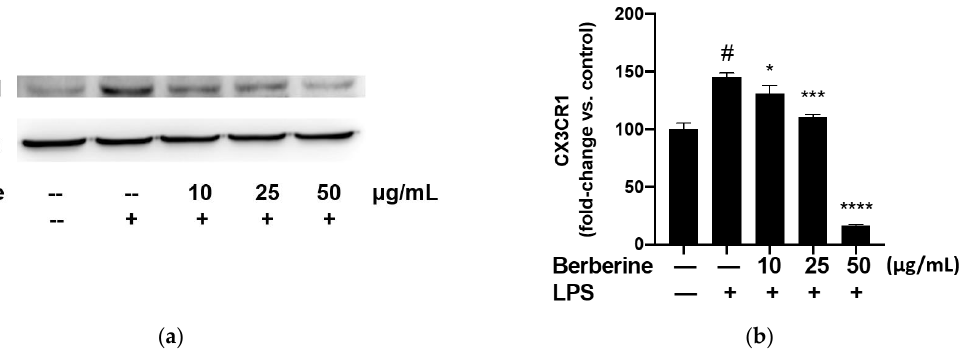
or 50 µg/mL berberine significantly and dose-dependently mitigated the LPS-induced up- regulation of CX3CR1 in THP-1 cells. regulation of CX3CR1 in THP-1 cells.